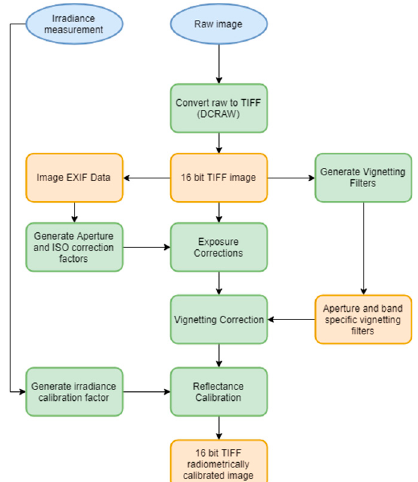
Figure 1. Flow chart of key processing steps used to convert raw images to reflectance images. The blue circles indicate inputs, green squares indicate processing steps and yellow squares derived